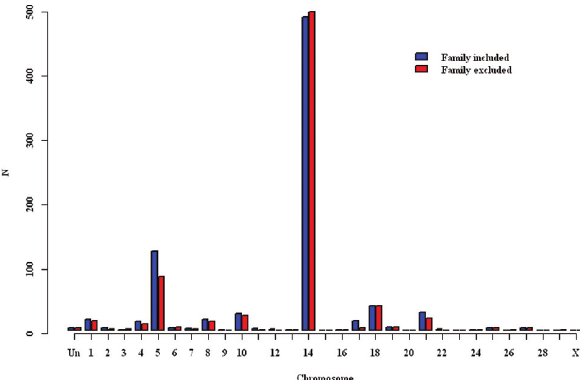
Figure 2 - Number of detected SNP loci associated with birth weight by chromosome from analyses with modeled pedigree relatedness with and without the fixed effect of family (“Un” represents SNP that were not as- signed to any chromosome).